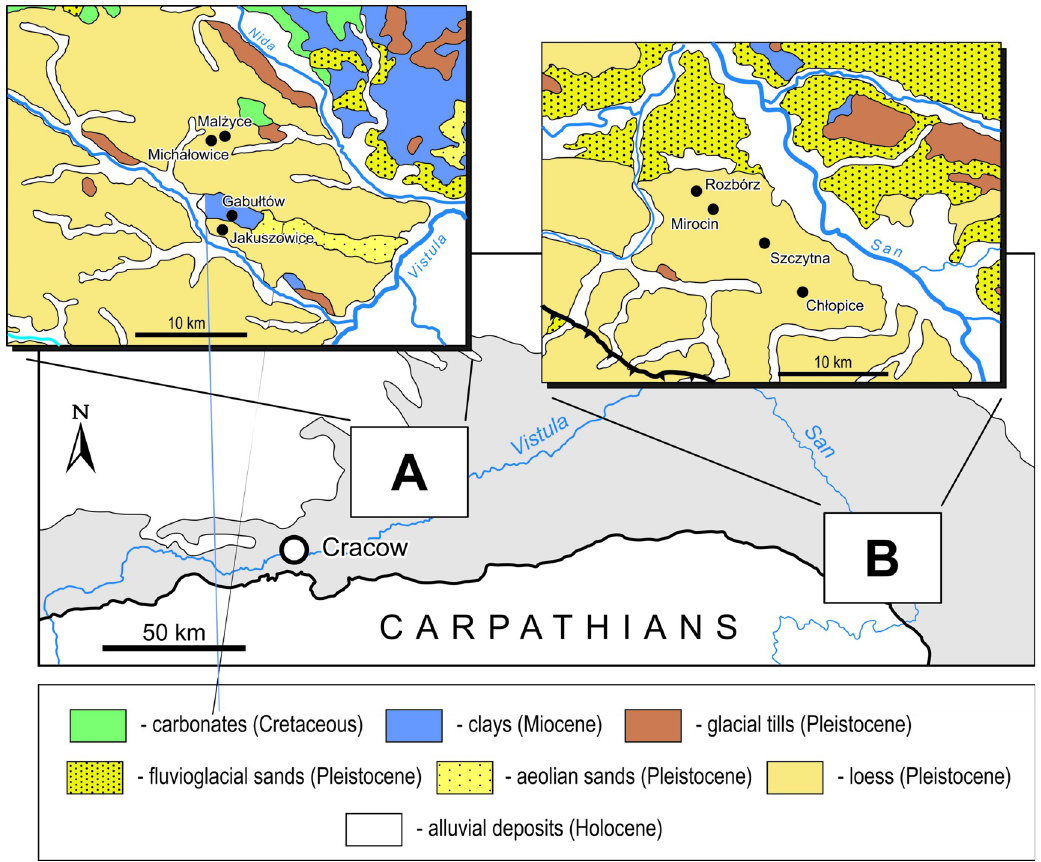
Fig 4. Schematic map of south-eastern Poland with the location of settlement areas of the Corded Ware culture in the Małopolska Upland (A) and the Subcarpathian region (B) investigated during the present study. The main geological units, the Carpathians and the Carpathian Foredeep (grey shading), are indicated. Detailed geological maps with the location of the investigated sites include information from the Geological Map of Poland [51].